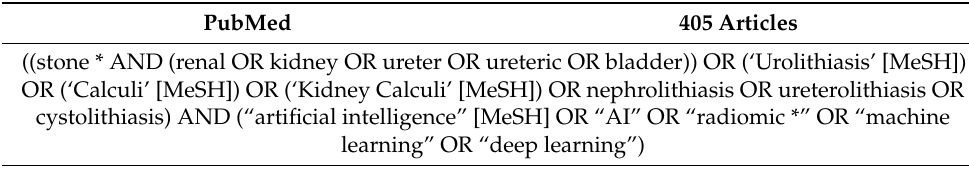
Table A1. Full search phrases used for the respective databases. PubMed 405 Articles ((stone * AND (renal OR kidney OR ureter OR ureteric OR bladder)) OR (‘Urolithiasis’ [MeSH]) OR (‘Calculi’ [MeSH]) OR (‘Kidney Calculi’ [MeSH]) OR nephrolithiasis OR ureterolithiasis OR cystolithiasis) AND (“artificial intelligence” [MeSH] OR “AI” OR “radiomic *” OR “machine learning” OR “deep learning”) EMBASE 713 articles ((stone OR stones) AND (renal OR kidney OR ureter OR ureteric OR bladder) OR ‘urolithiasis’/exp OR ‘calculi’/exp OR ‘nephrolithiasis’/exp OR ‘ureterolithiasis’/exp OR cystolithiasis) AND (‘artificial intelligence’/exp OR ‘ai’ OR ‘radiomic’ OR ‘radiomics’/exp OR ‘machine learning’/exp OR ‘deep learning’) Scopus 214 articles TITLE-ABS-KEY (((stone OR stones OR calculi OR calculus AND (renal OR kidney OR ureter OR ureteric OR bladder)) OR urolithiasis OR nephrolithiasis OR ureterolithiasis OR cystolithiasis) AND (“artificial intelligence” OR “AI” OR “radiomic” OR “radiomics” OR “machine learning” OR “deep